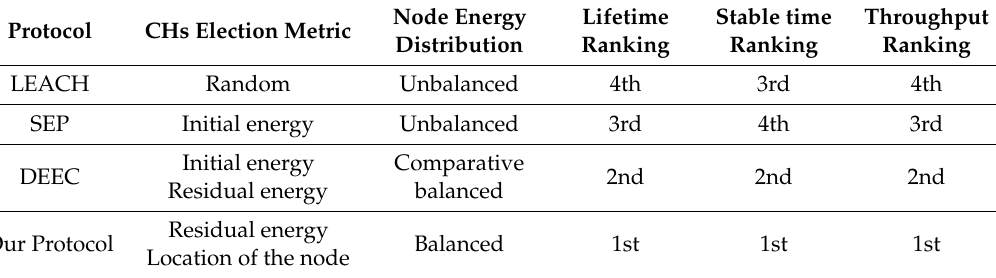
Table 8. A performance comparison between the four clustering protocols in the heterogeneous